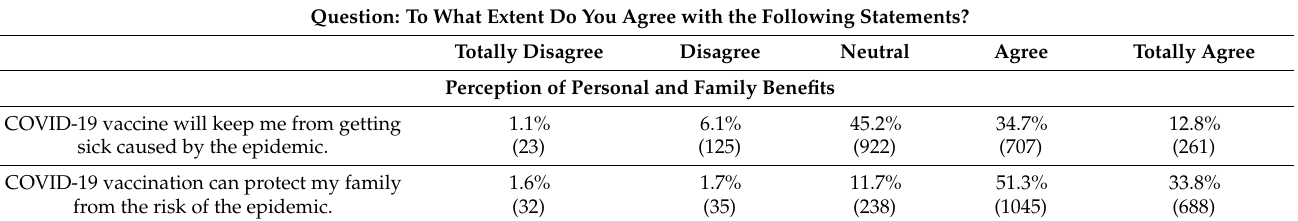
Table 4. Participants’ perception of personal and family benefits from COVID-19 vaccination ( n = 2038).